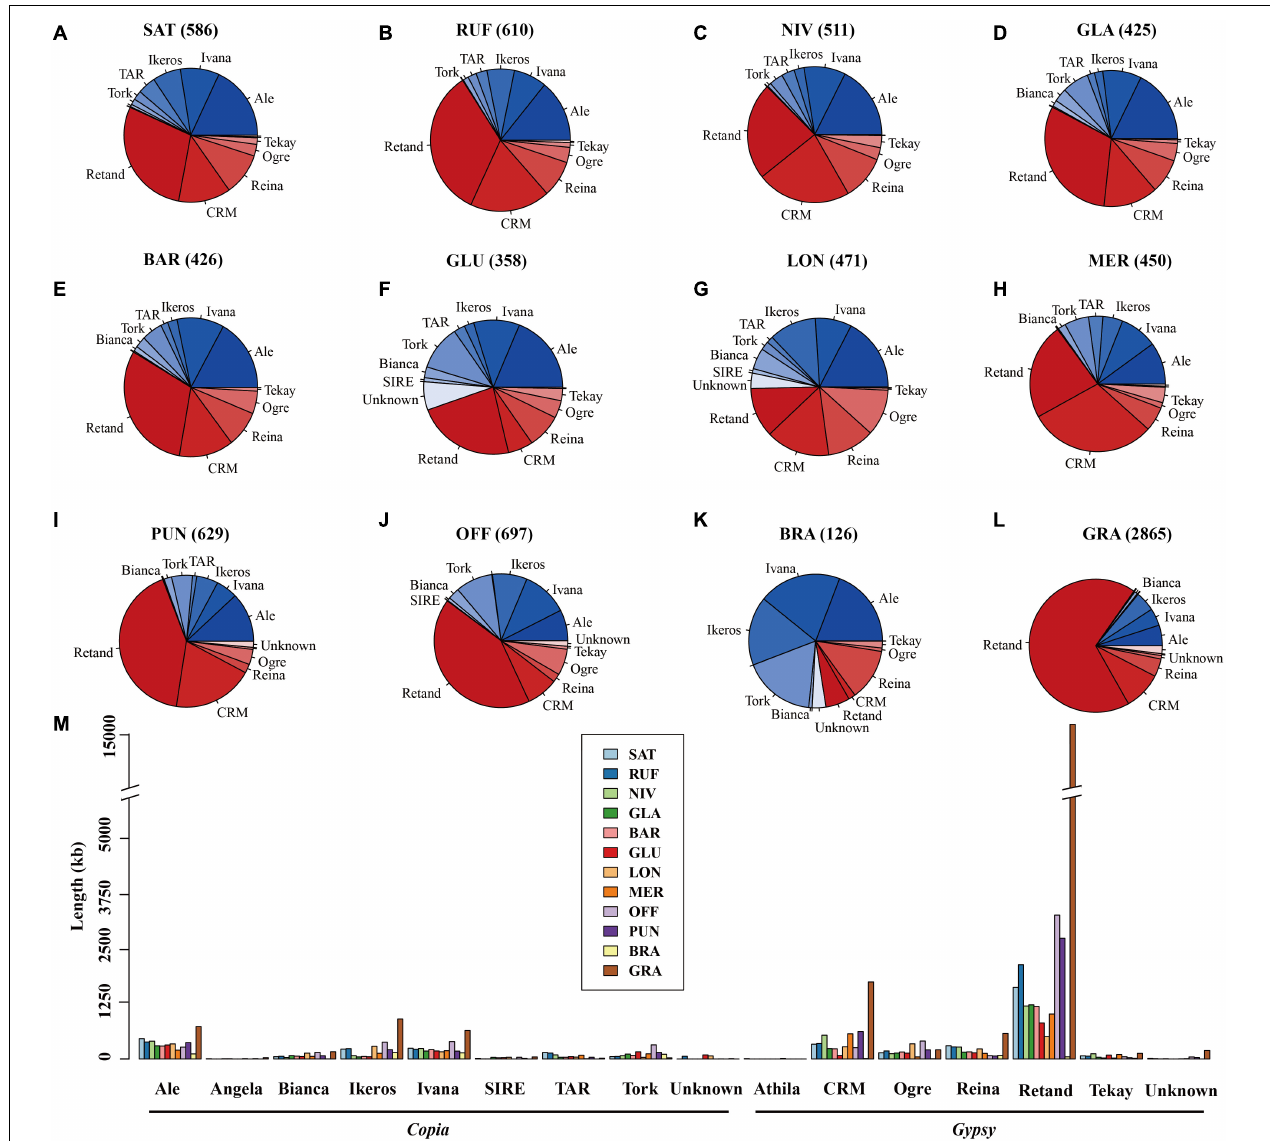
FIGURE 3 | Copy number (A–L) and length (M) of intact LTR-RTs in different lineages of the Oryza genomes. (A–L) Shows the classification and proportions of intact LTR-RTs in corresponding species; the lineages belonging to the Gypsy and Copia superfamilies are shown in red and blue color, respectively. The numbers in brackets represent the copy number of intact LTR-RTs. (M) Shows the length of intact LTR-RTs of different lineages in the Oryza genomes. SAT, NIV, RUF, GLA, BAR, GLU, LON, MER, PUN, OFF, BRA, and GRA represent O. sativa , O. nivara , O. rufipogon , O. barthii , O. glaberrima , O. glumaepatula , O. longistaminata , O. meridionalis , O. punctata , O. officinalis , O. brachyantha, and O. granulata ,